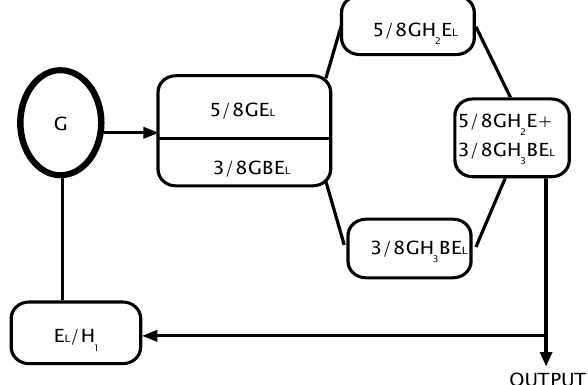
Figure 14. Schematic energy flow of the reactor with typical